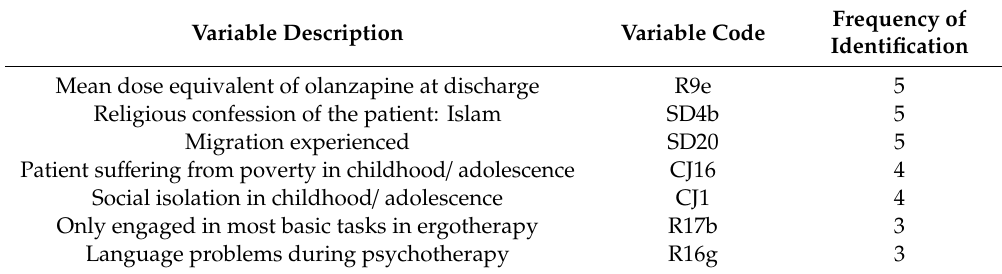
Table 2. Most important variables to di ff erentiate between European / non-European identified by at least three